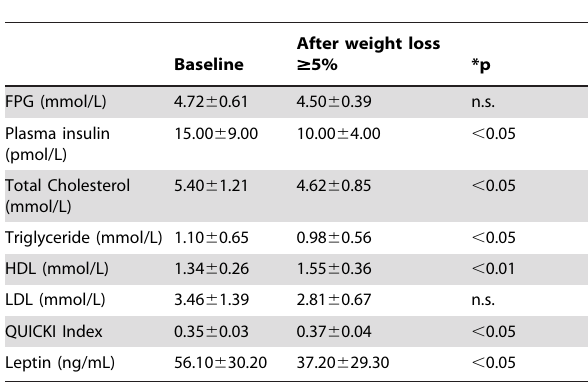
Table 2. Metabolic parameters of study population.